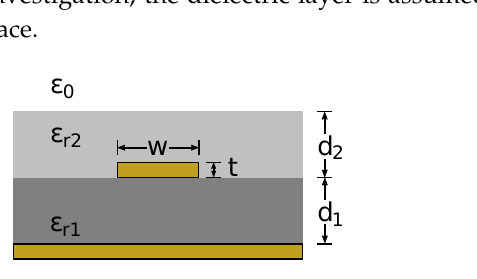
Figure 7. Cross-section of a microstrip transmission line with an optional dielectric